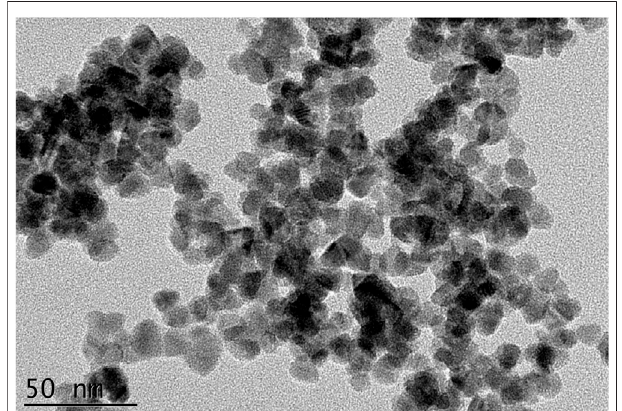
FIGURE 2 | SEM image of LY@ZnO NPs.